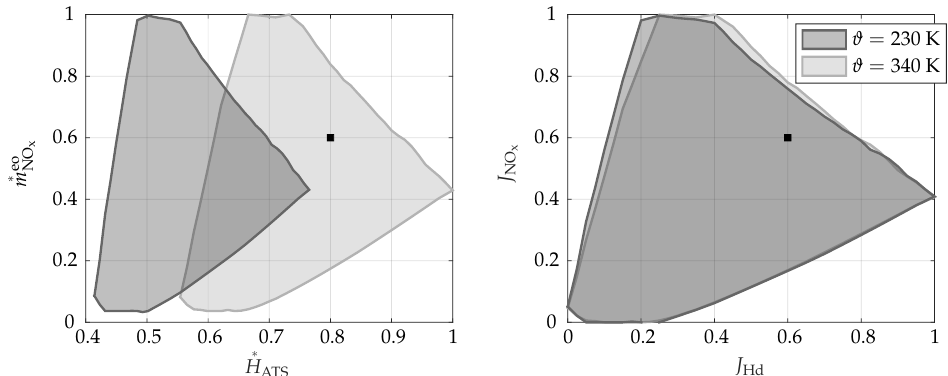
Figure 5. Outline of the Pareto front for fixed engine speed and torque and two values of the ATS temperature. The plot on the right shows values normalized using a constant value. The plot on the left shows values scaled using Equations (11) and (12). The square marker represents an exemplary evaluation point.